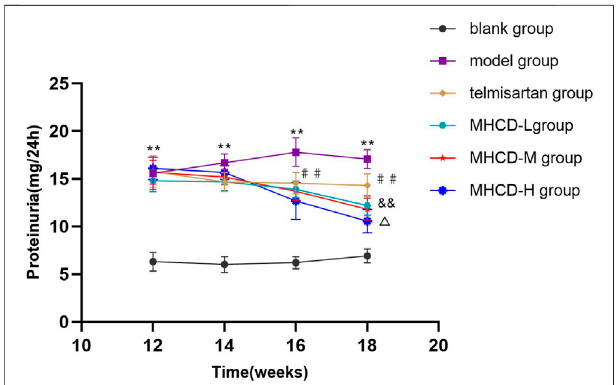
FIGURE 3 | MHCD ameliorates proteinuria over time. Data are expressed as means ± SD ( n (cid:1) 10). ** p < 0.01 vs. blank group; ＃＃ p < 0.01 vs. model group; && p < 0.01 vs. Telmisartan group; △ p < 0.05 vs. MHCD-L group. MHCD, modi fi ed Huangqi Chifeng